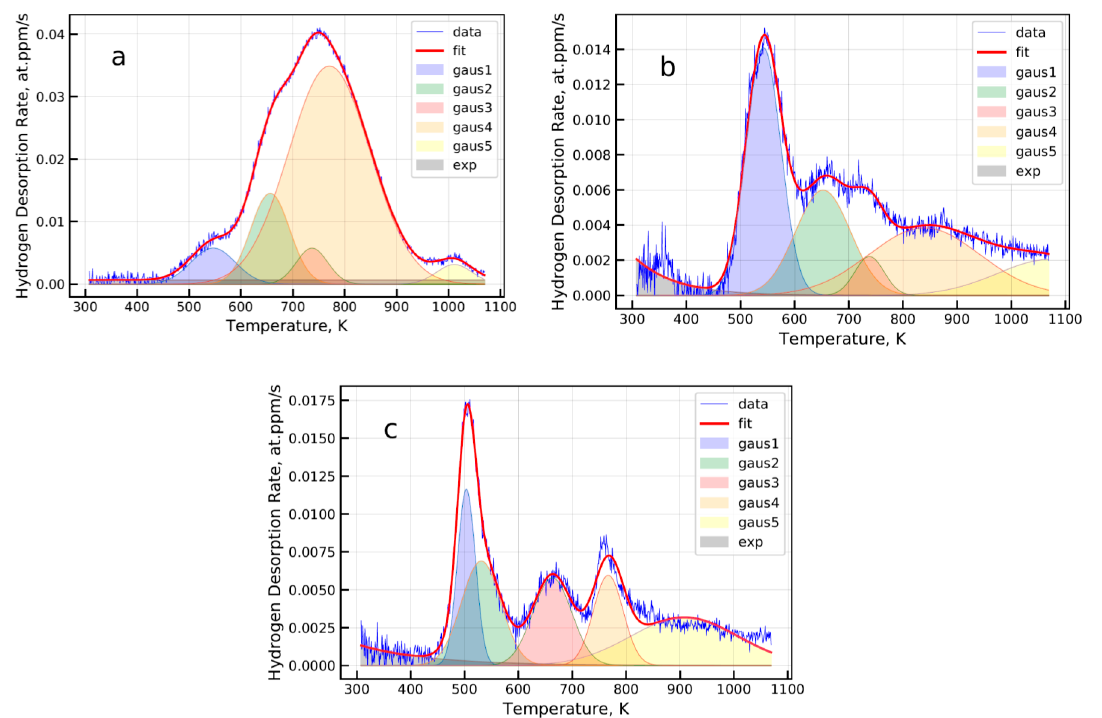
Figure 2. Examples of the thermal desorption spectroscopy of hydrogen from the as-supplied ( a ) austenitic stainless steel, ( b ) ferritic stainless steel, and ( c ) ferritic–martensitic high-strength steel. Spectroscopy curves are fitted with the sum of five Gaussian peaks and exponential background.